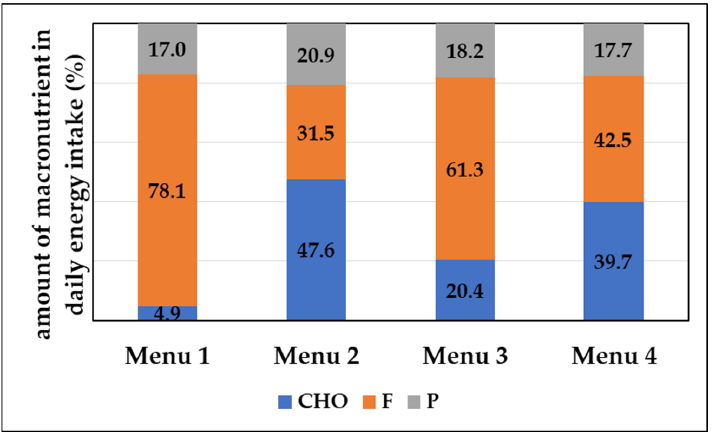
Figure 2. Percentage of macronutrients in daily energy intake (%). (CHO—carbohydrates, F—fats, P—proteins).